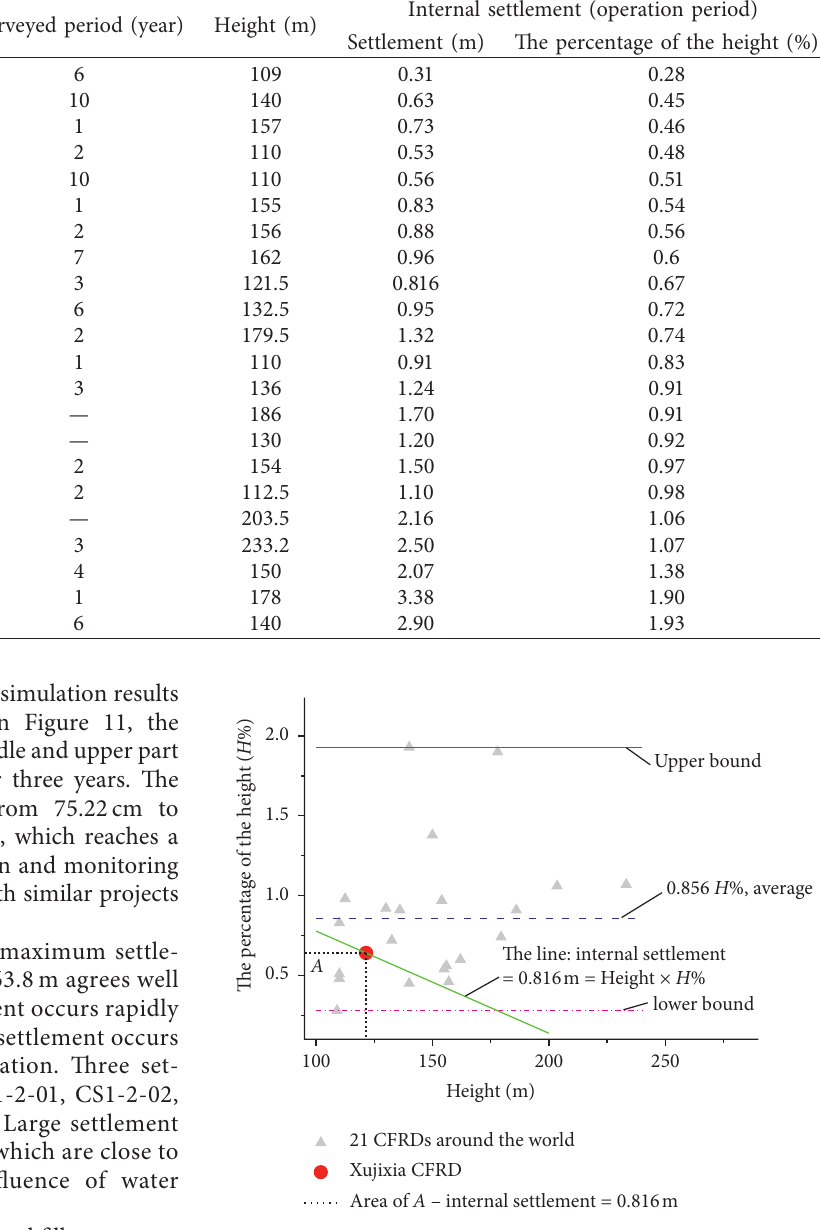
Figure 12: Comparison of the settlement of the Xujixia CFRD and other 100-meter high